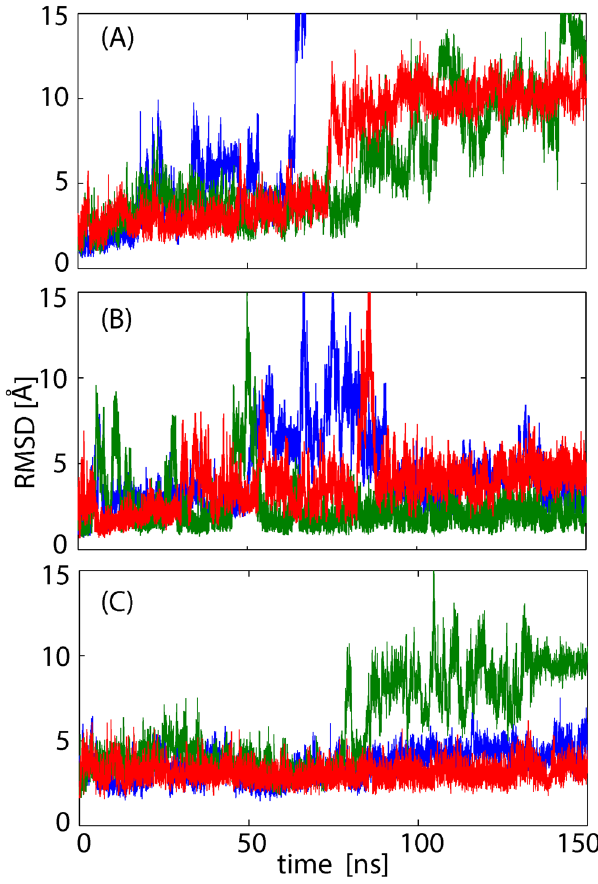
Figure 5. MD simulations of mono-Ub/TAB2 NZF. ( A ) Time courses of C α RMSD values for three 150-ns MD simulations (colored in red, blue, and green) from the crystal structure of distal Ub/TAB2 NZF (PDB: 2wwz as the reference structure). The blue curve overshoots the upper range of the figure. ( B ) Those of proximal Ub/ TAB2 NZF. ( C ) Those of mono-Ub/Npl4 NZF (PDB: